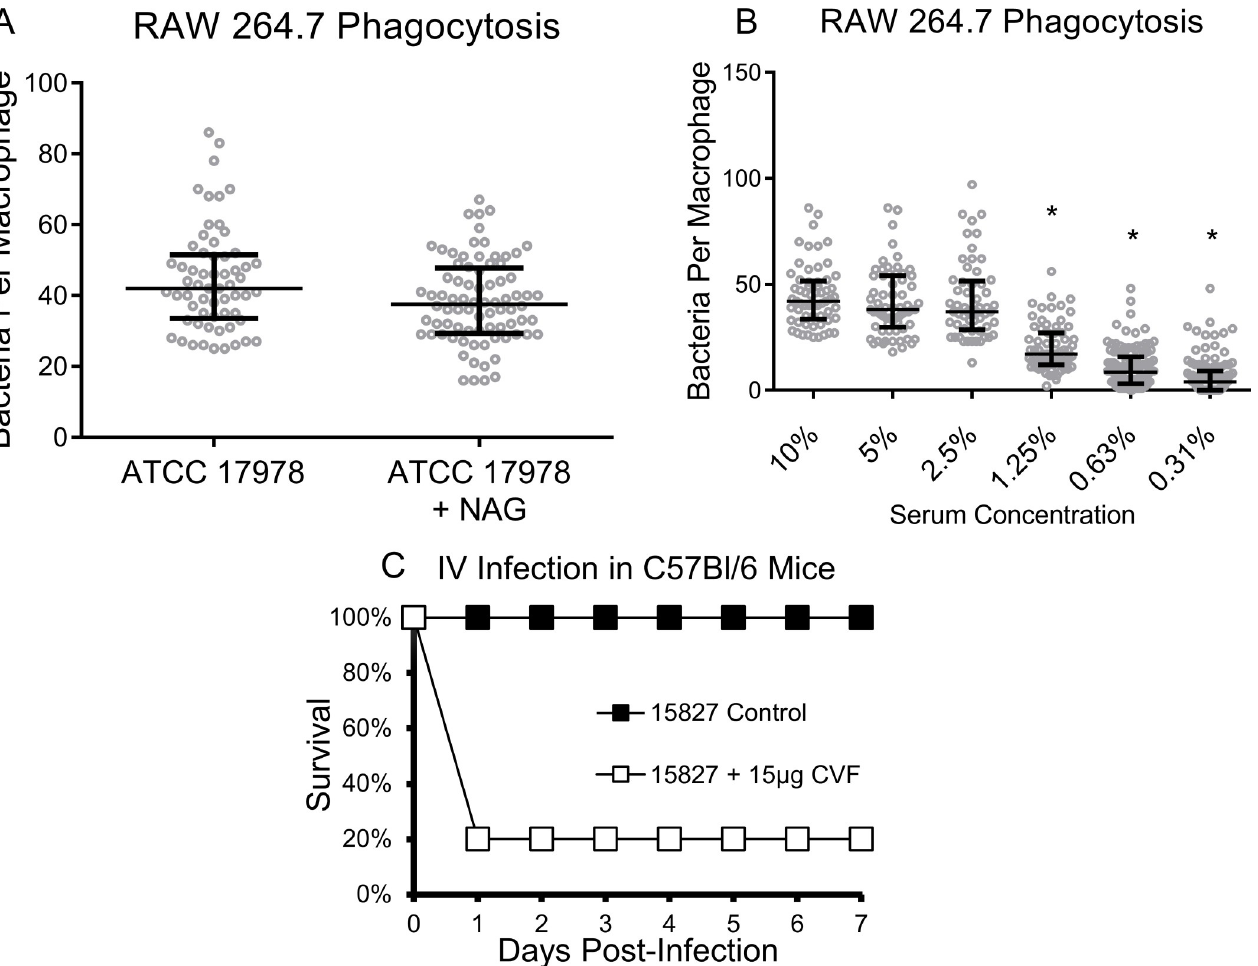
Fig 6. Phagocytosis in the presence of a lectin domain inhibitor, phagocytosis by macrophages in serially diluted serum, and infection of complement- depleted mice. (6A) Incubation of RAW 264.7 cells with ATCC 17978 in the presence of 100 μ g/mL GlcNAc (NAG), a CR3 lectin domain inhibitor. (6B) Serial two-fold dilutions of complement-active mouse serum in a RAW 264.7 cell phagocytosis assay with ATCC 17978. � p < 0.0001 (6C) Male C57BL/6 mice aged 10 weeks were infected intravenously with 2.0 × 10 8 CFUs of 15827, with or without administration of 15 μ g cobra venom factor (CVF) 48 h prior to infection. � p < 0.001. Experiments repeated once, n = 5 per group for in vivo and two technical replicates for in vitro .